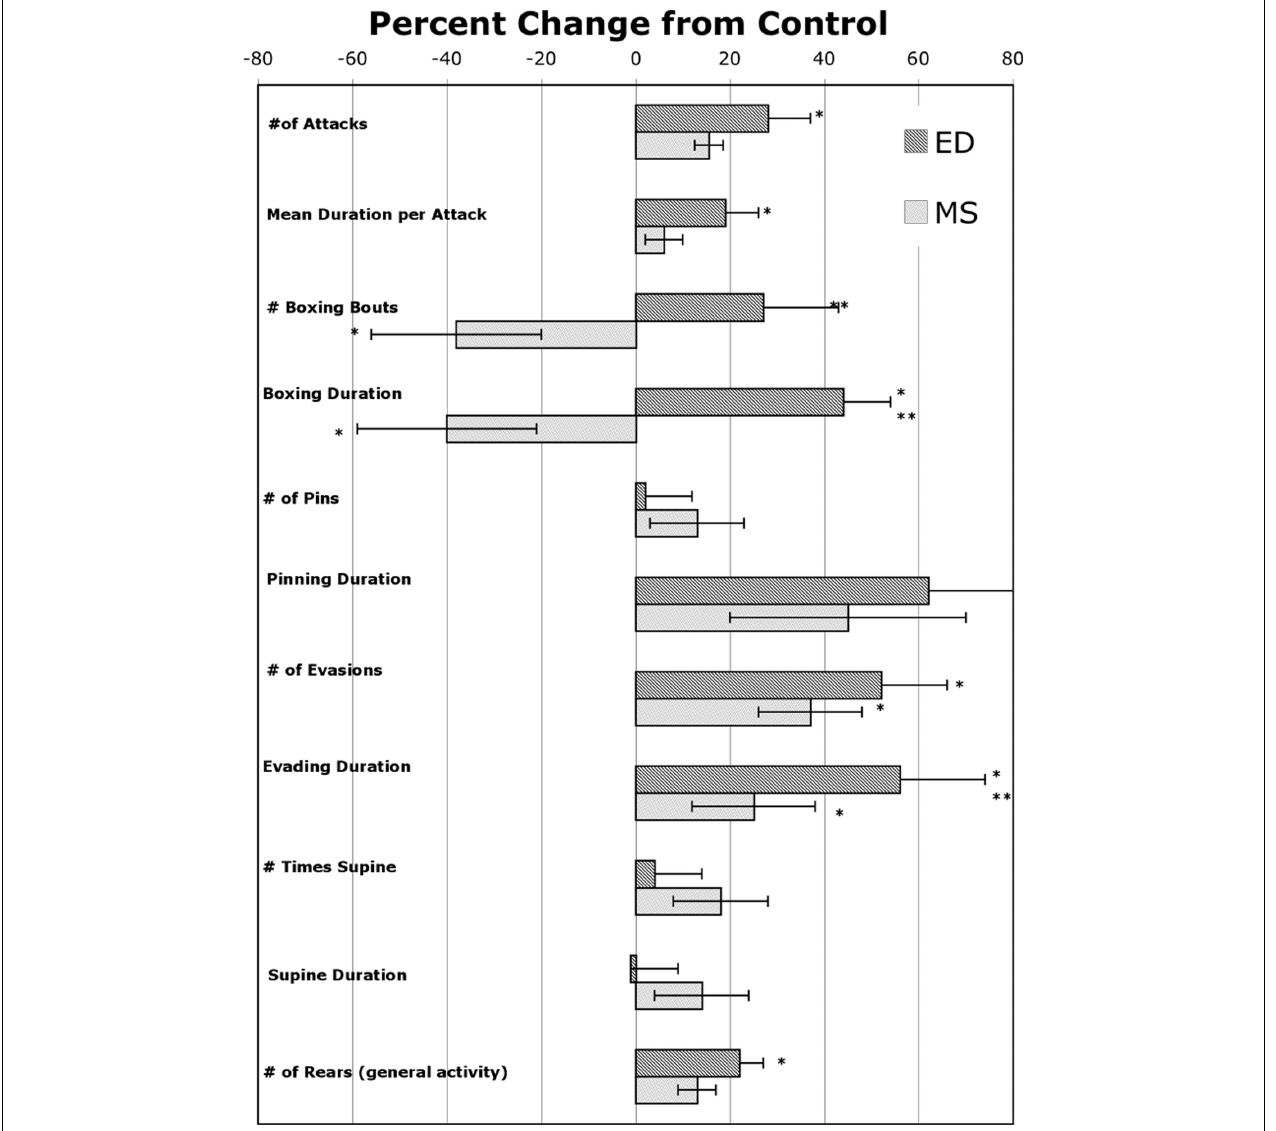
FIGURE 1 | Percent change ( + SEM) from Control for play and activity measures for rats with an early experience of maternal separation (MS) or early deprivation (ED). *Significantly different from control. **Significantly different from